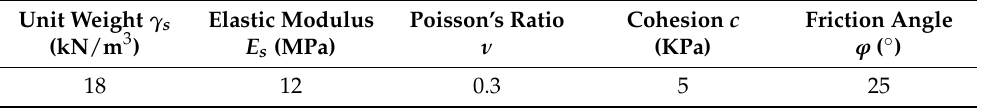
Table 1. Physical–mechanical parameters of